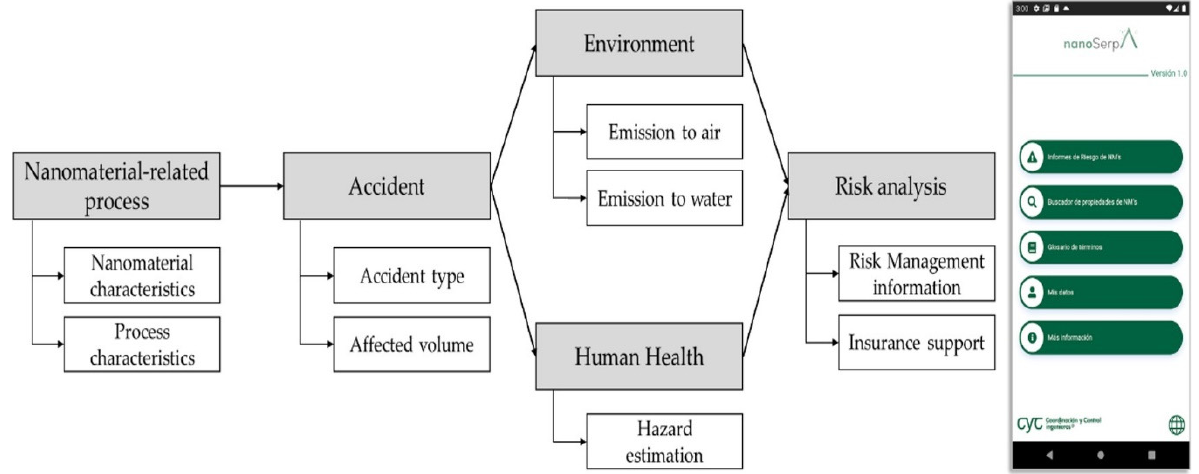
Figure 1. NanoSerpa application flow diagram ( left ) and screenshot of the app ( right ).